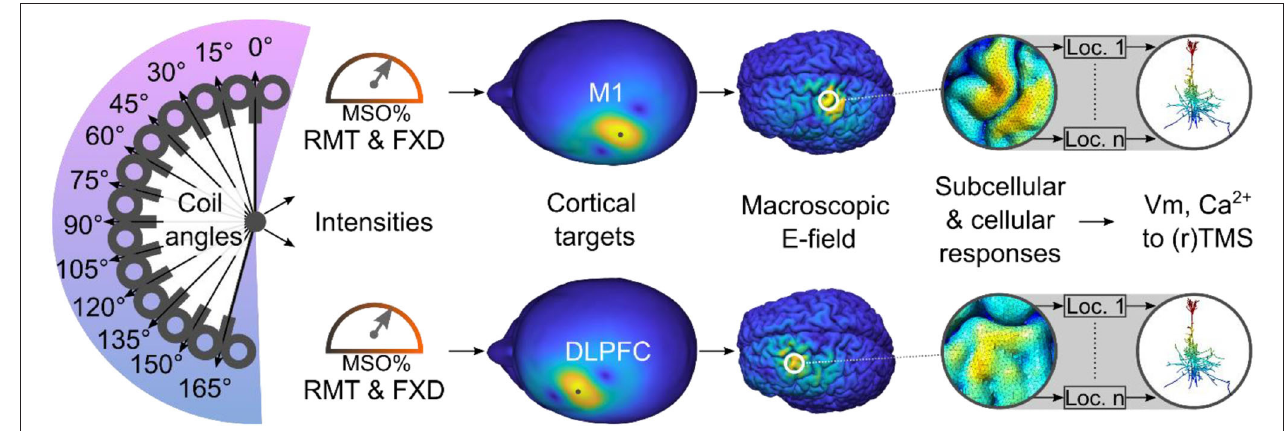
FIGURE 1 | Study overview. Using a multi-scale computational approach, we modeled the TMS-induced macroscopic E-field and the subcellular/cellular responses to (r)TMS in the M1 and DLPFC using conventional stimulation intensities. Ca 2 + , calcium concentration; DLPFC, dorsolateral prefrontal cortex; FXD, fixed stimulation intensity; Loc., location of cell; M1, primary motor cortex; MSO%, maximum stimulator output percentage; RMT, resting motor threshold; Vm, membrane voltage.